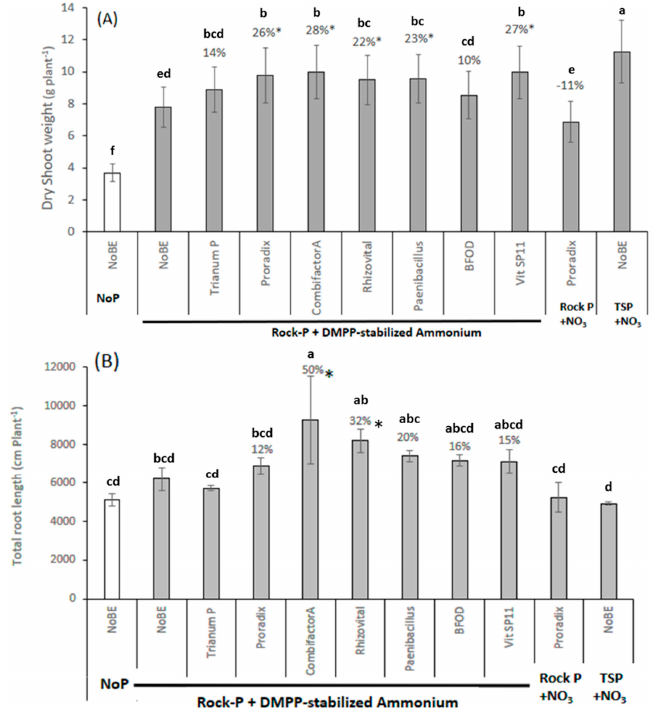
Figure 3. Shoot biomass ( A ) and total root length ( B ) of maize (cv Colisee) grown on a clay-loam, organic farming soil (pH 7.0), supplied with and without (No P) P fertilization in form of Rock-P or soluble triple superphosphate (TSP). N supply in the form of Ca-nitrate (NO 3 ) or DMPP-stabilized ammonium. Microbial inoculants: Trichoderma harzianum T22 (Trianum P), Pseudomonas sp. DSMZ 13134 (Proradix), Trichoderma harzianum OMG16 + 5 Bacillus strains (Combifector-A); Bacillus amyloliquefaciens FZB42 (Rhizovital), Paenibacillus mucilaginosus , Penicillium sp. PK 112 (BFOD), Vitalin SP11 (VitSP11), or no inoculation (NoBE). Means of five replicates. One-way ANOVA, Tukey test. Different letters indicate significant differences ( P < 0.05); * indicates significant differences after pairwise comparison of PSM-inoculated variants versus the non-inoculated control with ammonium fertilization ( t -test, P < 0.05).